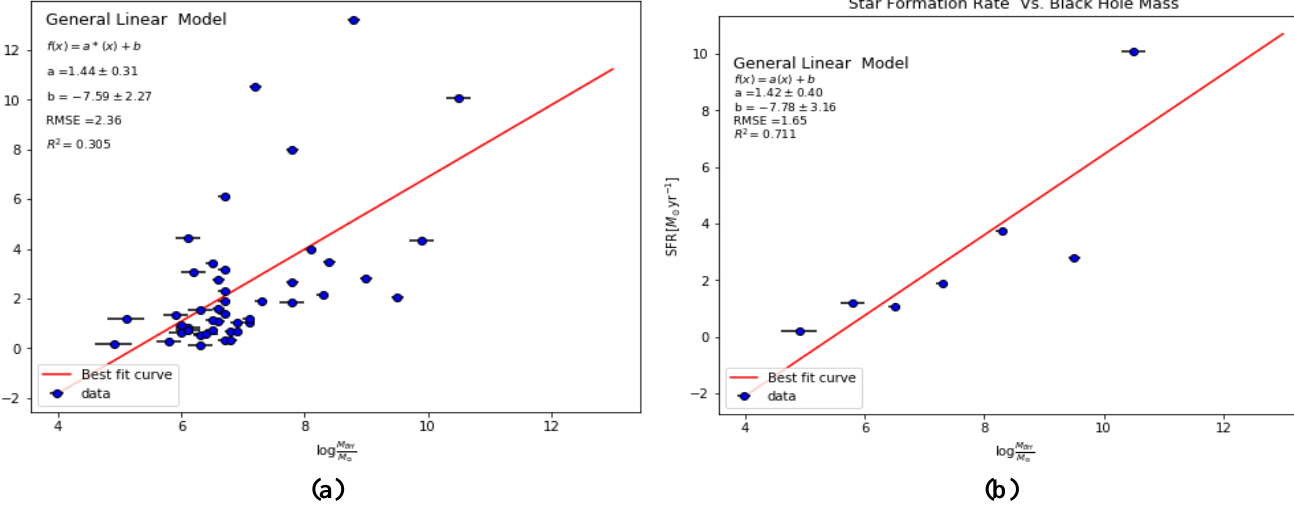
Fig.4: The correlation between the SMBH & SFR for seyfert2 galaxies using linear regression, where (a) for all samples, (b) median